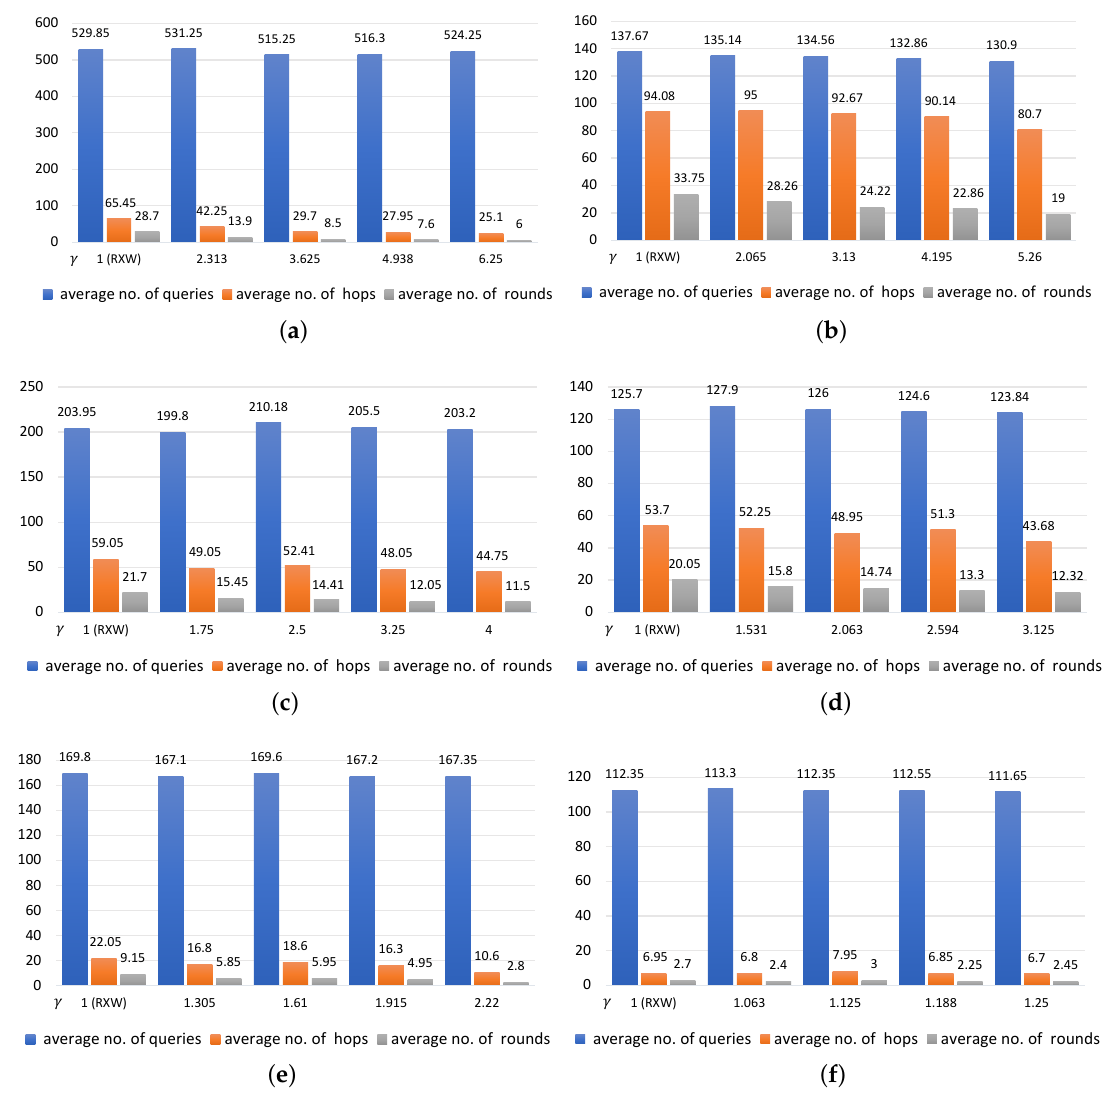
Figure 6. Comparing RXW and RXW-G: the number of queries sent to regions and number of hops and number of rounds averaged over 20 runs (vertical axis) for varying γ (horizontal axis) for different values of σ with k = 100. ( a ) σ = 0.16 ( α = 0.20 , β = 0.80 ) ; ( b ) σ = 0.19 ( α = 0.75 , β = 0.25 )